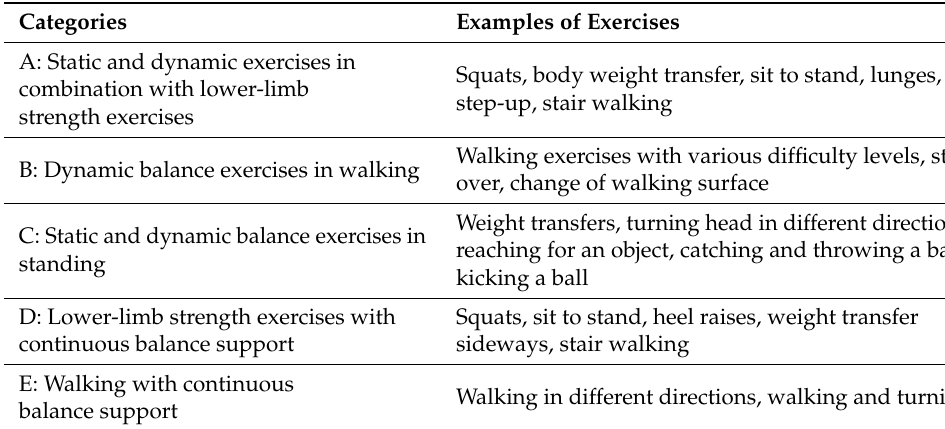
Table 1. Categories and examples of HIFE exercises.